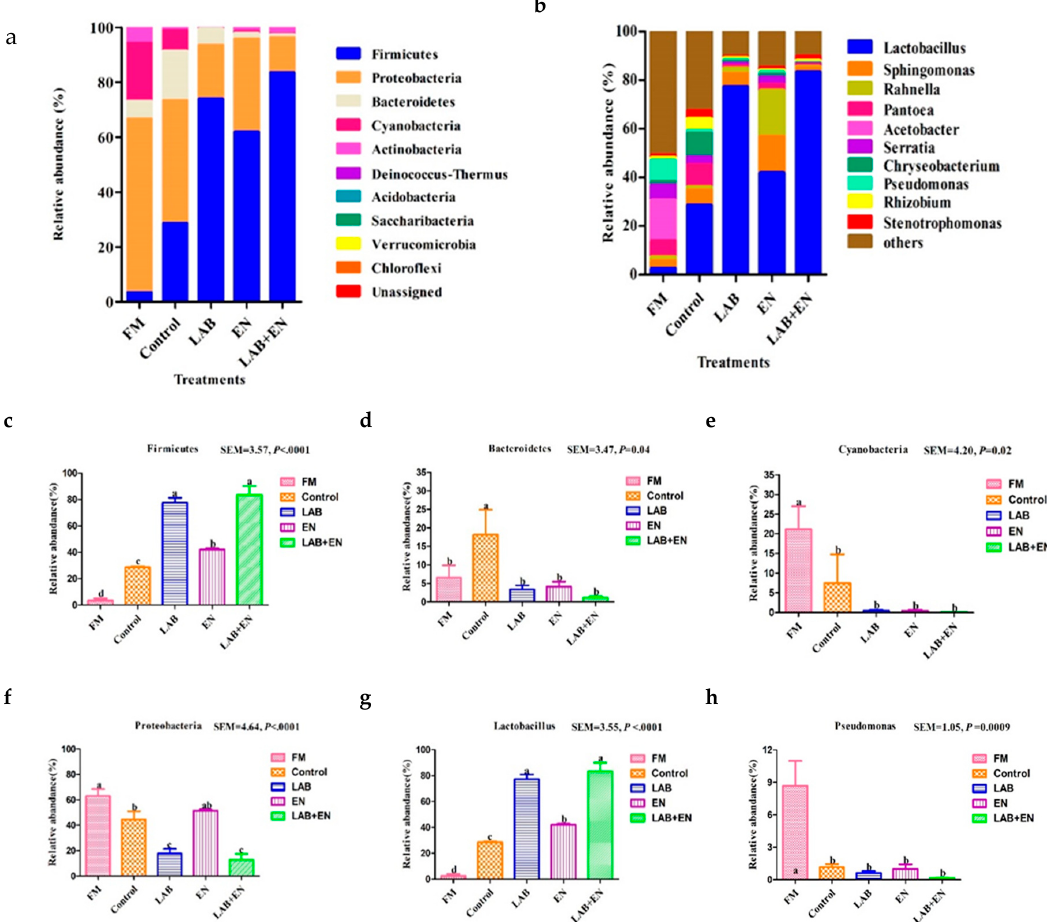
Figure 2. The microbial community of fresh materials and silages after 30 days of ensiling revealed by next-generation sequencing. ( a ), phylum; ( b ), genus level; ( c ) Firmicutes ; ( d ) Bacteroidetes ; ( e ) Cyanobacteria ; ( f ) Proteobacteria ; ( g ) Lactobacillus ; ( h ) Pseudomonas . FM, fresh material; SEM, standard error of mean. Treatments, control, no additive; LAB, lactic acid bacteria; EN, 1 g fibrolytic enzyme per 1 kg FM; LAB + EN: combine lactic acid bacteria with 1 g fibrolytic enzyme per 1 kg